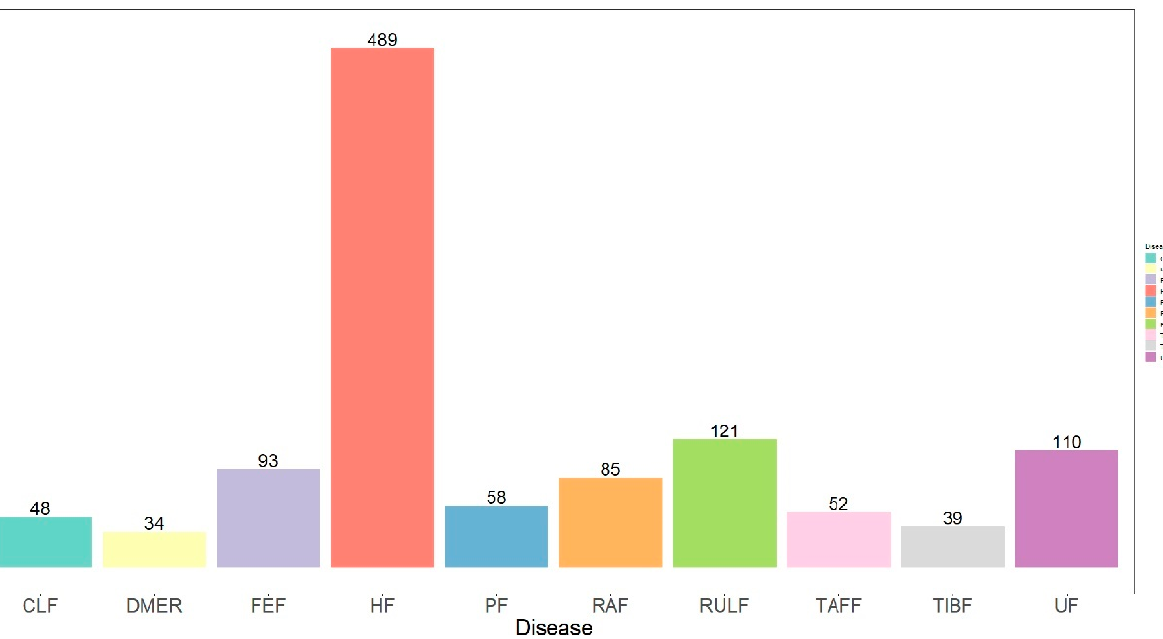
Figure 5. Distribution of causes in pediatric bone patients from 2006 to 2021. Legend : CMER (22, 1.94%) consists of BI (3 cases), CY (7 cases), PCP (5 cases), and OUR (7 cases). Birth injury (BI); excise machine injury (EM), referring to falling with greater momentum involving sports equipment re- ferring to skating, skiing, rollerblading, skateboarding or bicycle riding, etc.; falling from one plane to another (FPA), referring to bed, chair, sofa, stairs or steps, etc.; falling on the same plane (OSAP), referring to slip, trip, etc., with small momentum; improper use of force (IUF), referring to repetitive